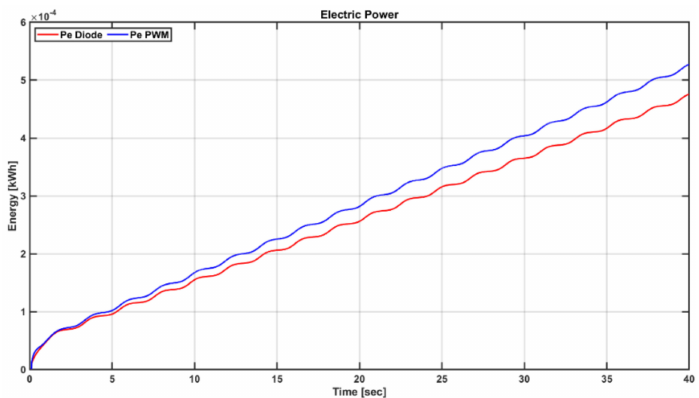
Figure 17. Output energy comparison using PTO system in integrated simulation at low regular wave conditions ( v t = 0~5 m / s and T = 4.25